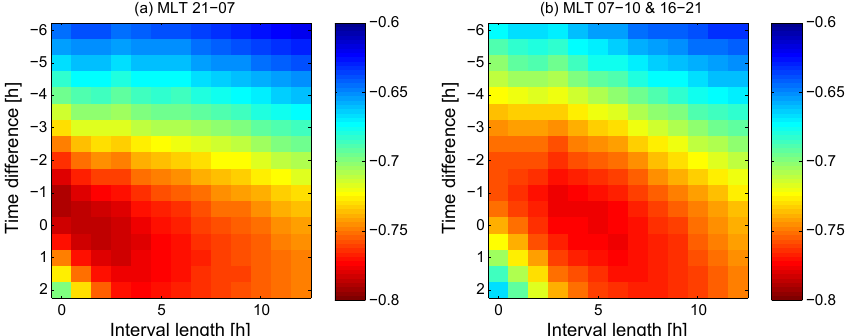
Figure 2. Correlation strength between the SSFAC index and the peak Kp as a function of the length of the interval (horizontal axis), where the peak Kp is taken from the time difference (vertical axis) between the end of the interval and SSFAC index observation (a) in the sector (MLT 21:00–07:00), and (b) for morning (MLT: 07:00–10:00) and evening (MLT: 16:00—21:00) hours.